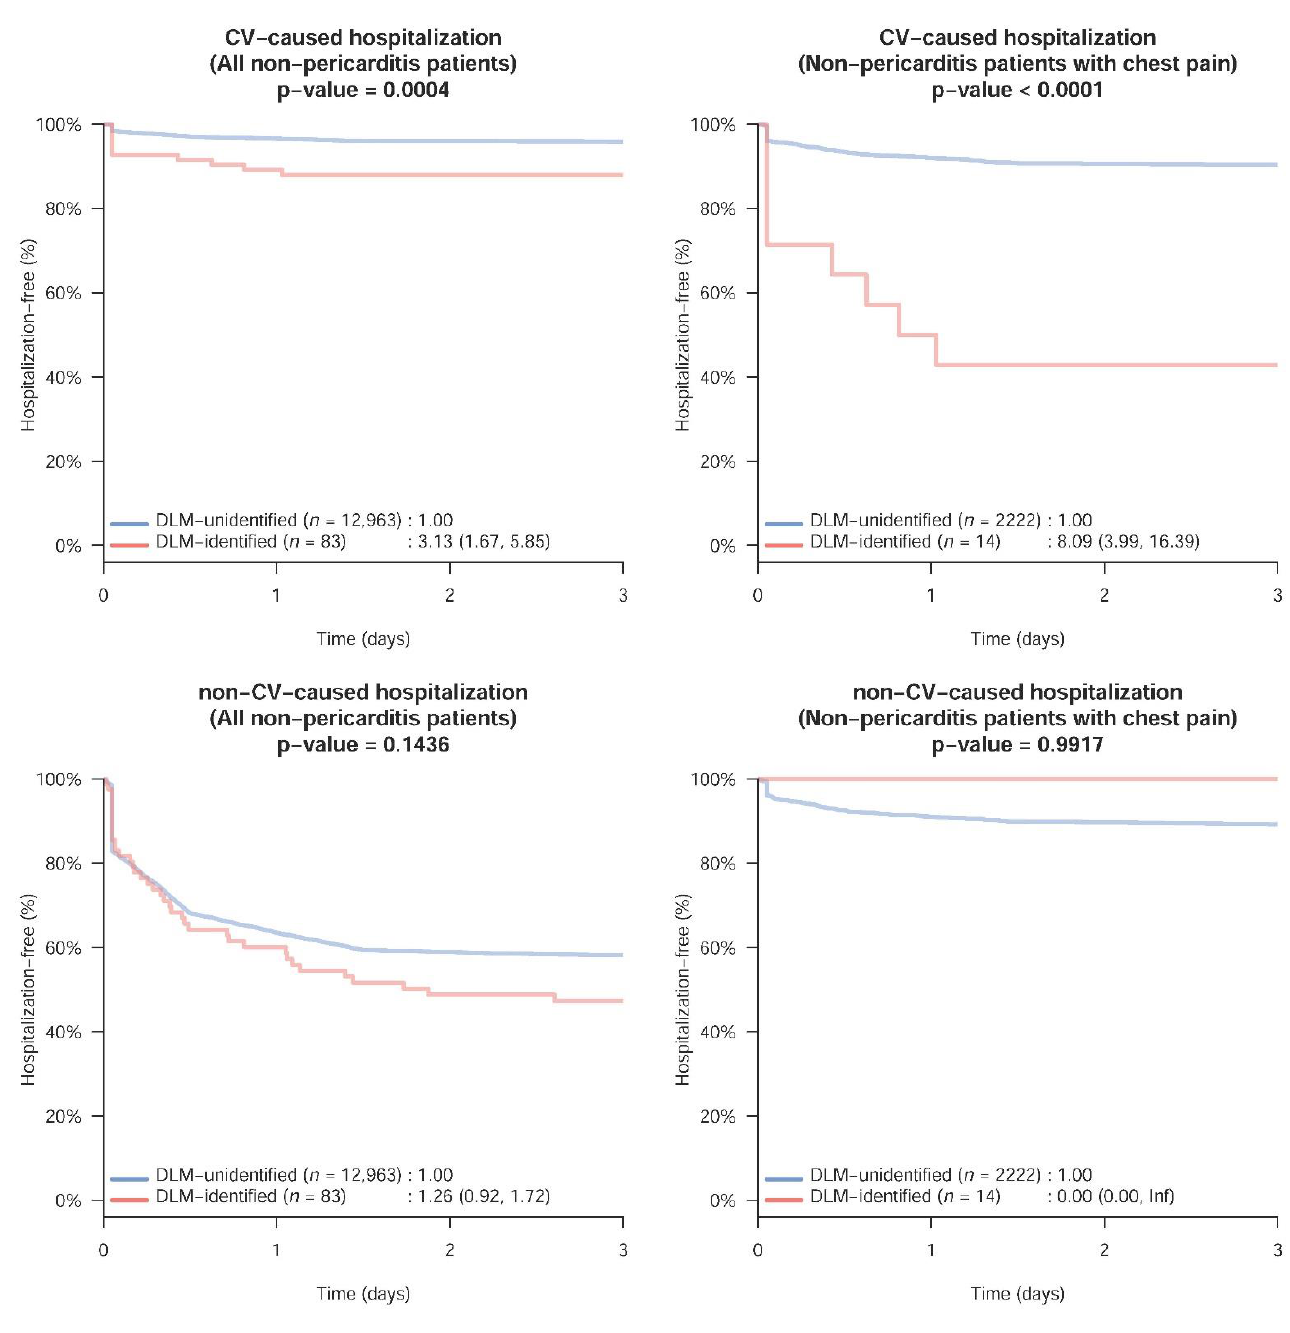
Figure 3. 3-day CV- and non-CV-caused hospitalization in non-pericarditis cases stratified by DLM classification. DLM identification was defined as the intersection of DLM-pericarditis and DLM- STEMI. A higher risk of 3-day CV-caused hospitalization was present when the DLM defined the ECG as abnormal compared with those who were classified as having a normal ECG by DLM. The numbers reported in the legend are the hazard